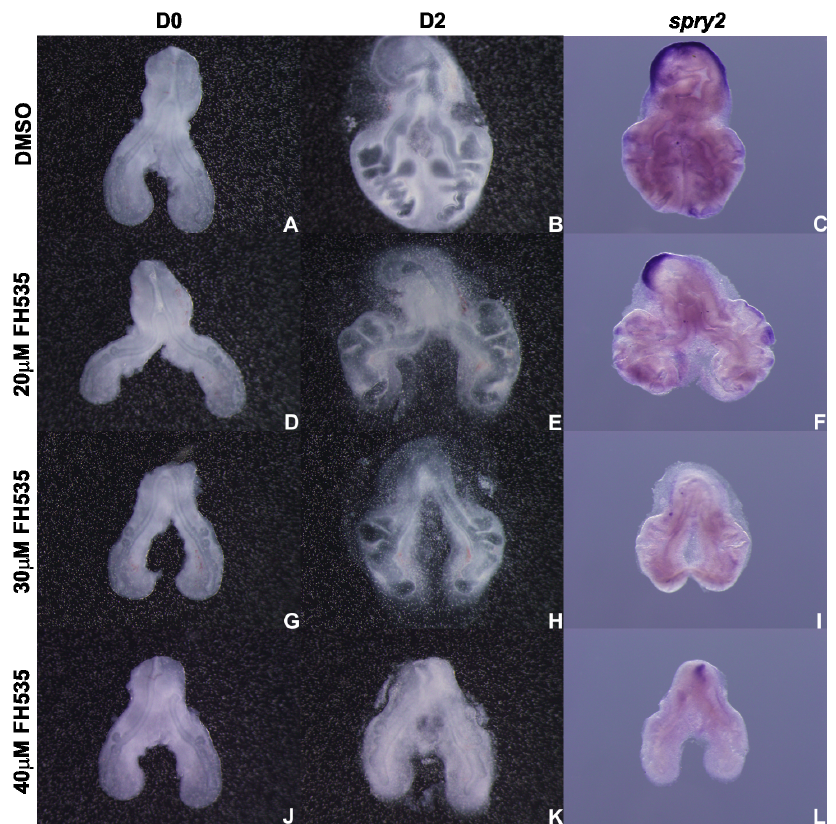
Figure 13. In vitro Wnt signaling inhibition and spry2 expression. Representative examples of stage b2 lung explant culture, at D0:0h (A, D, G, J) and D2:48h (B, E, H, K) treated with DMSO (A, B), 20 m M (D, E), 30 m M (G, H) and 40 m M FH535 (J, K) and probed with spry2 (C, F, I, L); n 5 3 for each stage. Magnification: A, B, D, E, G, H, J, K –4x; C, F, I, L –5x. The signal observed in the most proximal region of the lung is due to the accumulation of developing